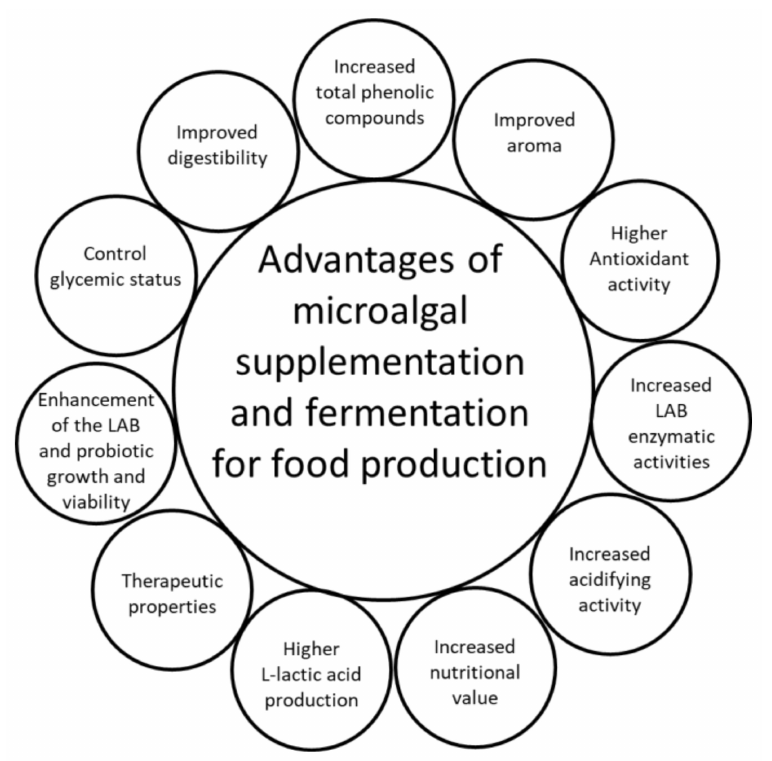
Figure 3. Advantages of microalgal supplementation and fermentation for potential use in innovative food production; LAB, lactic acid